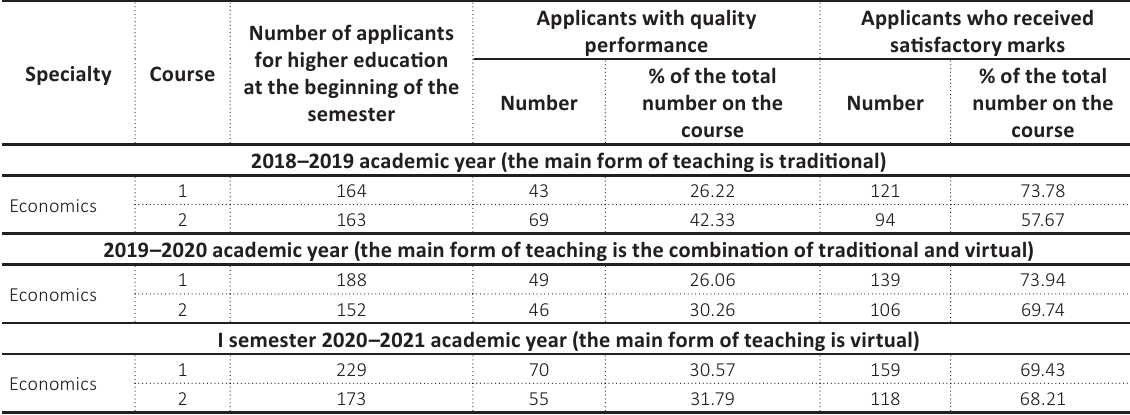
Table 4. Monitoring student learning outcomes for